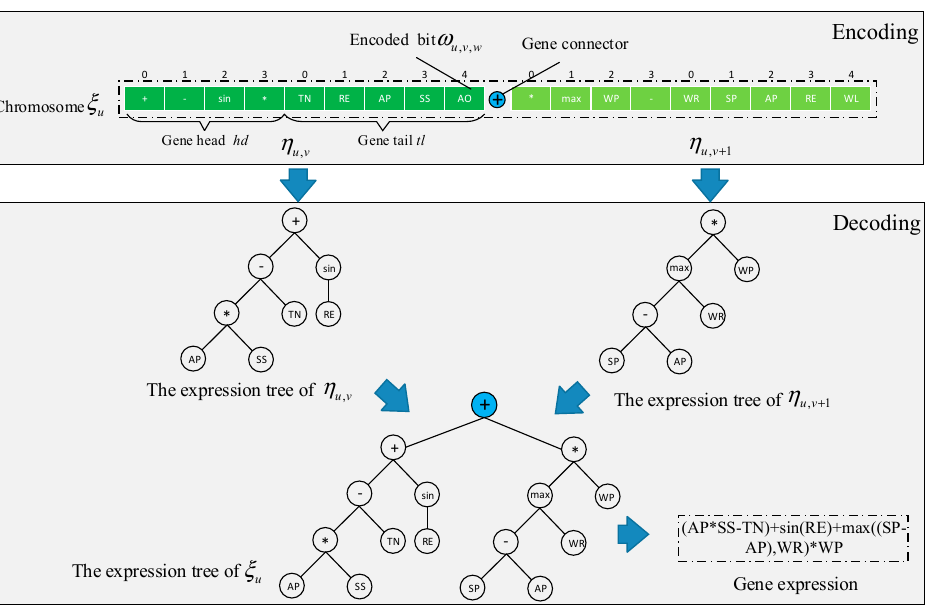
Figure 5. The encoding and decoding of the chromosome.